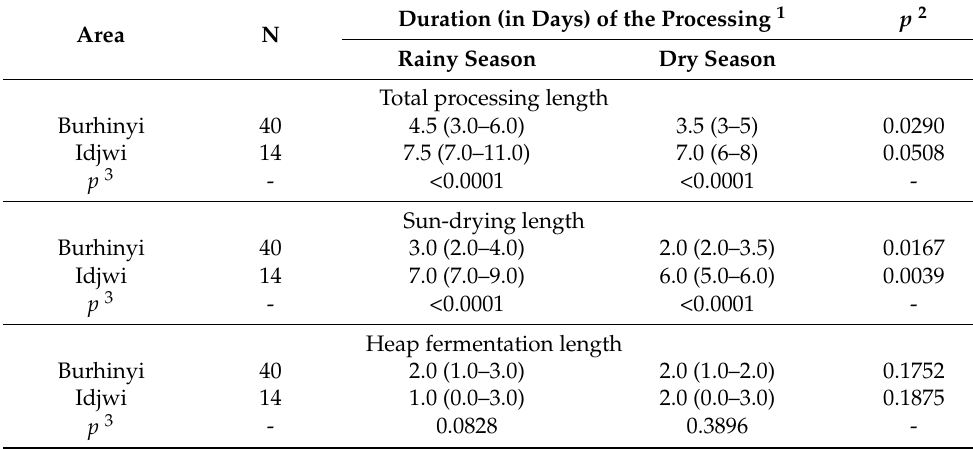
Table 3. Duration of cassava processing methods by seasons and areas.